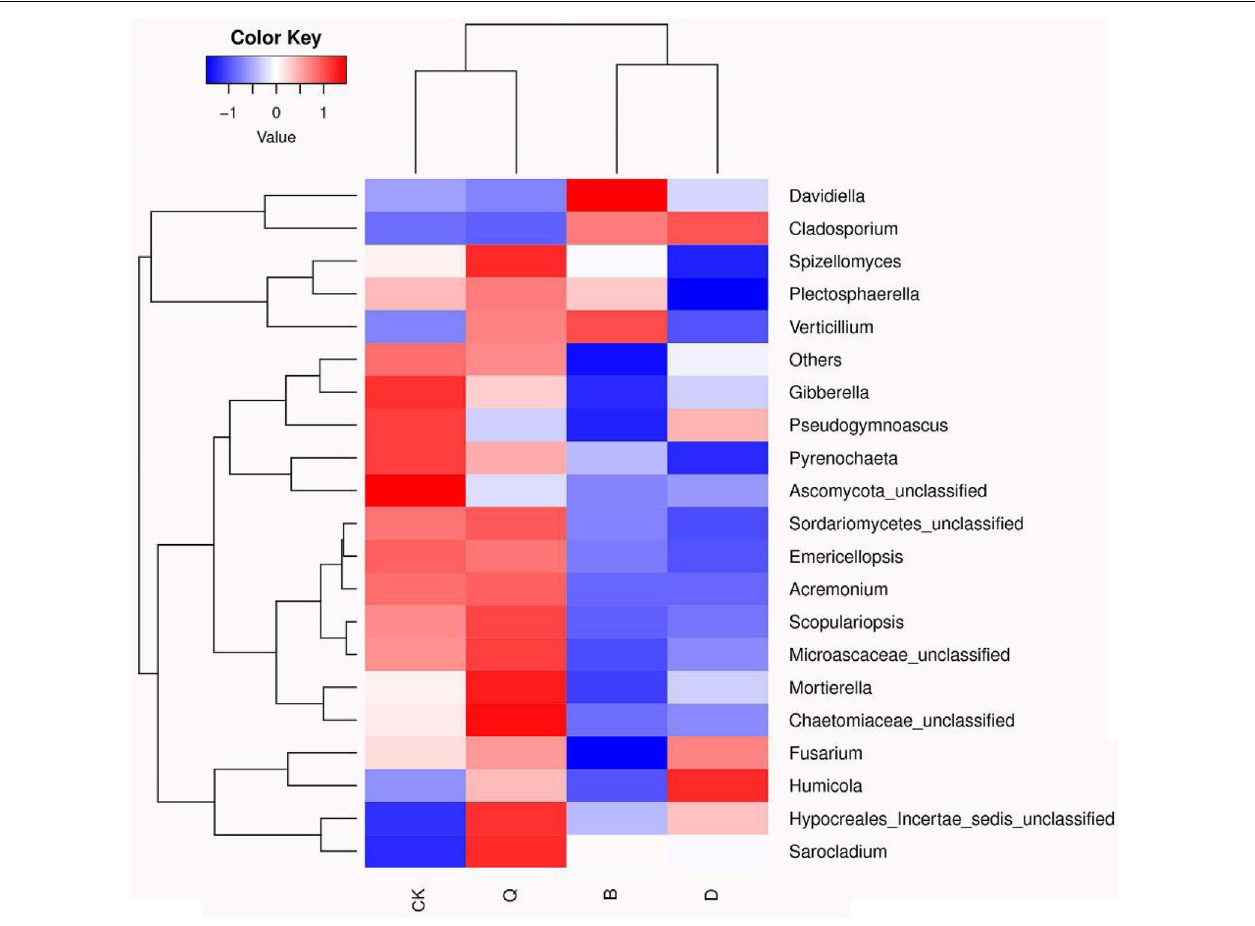
FIGURE 3 | Heatmap analysis of fungal communities in continuous tomato cropping substrates under different treatments. The color of relative abundance of the community changed from blue to red, indicating that the relative abundance of the community changed from low to high. Treatment abbreviations are defined in Figure 1